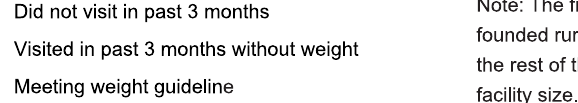
Fig 2. Percent of established patients meeting weight monitoring guidelines, 2009 –